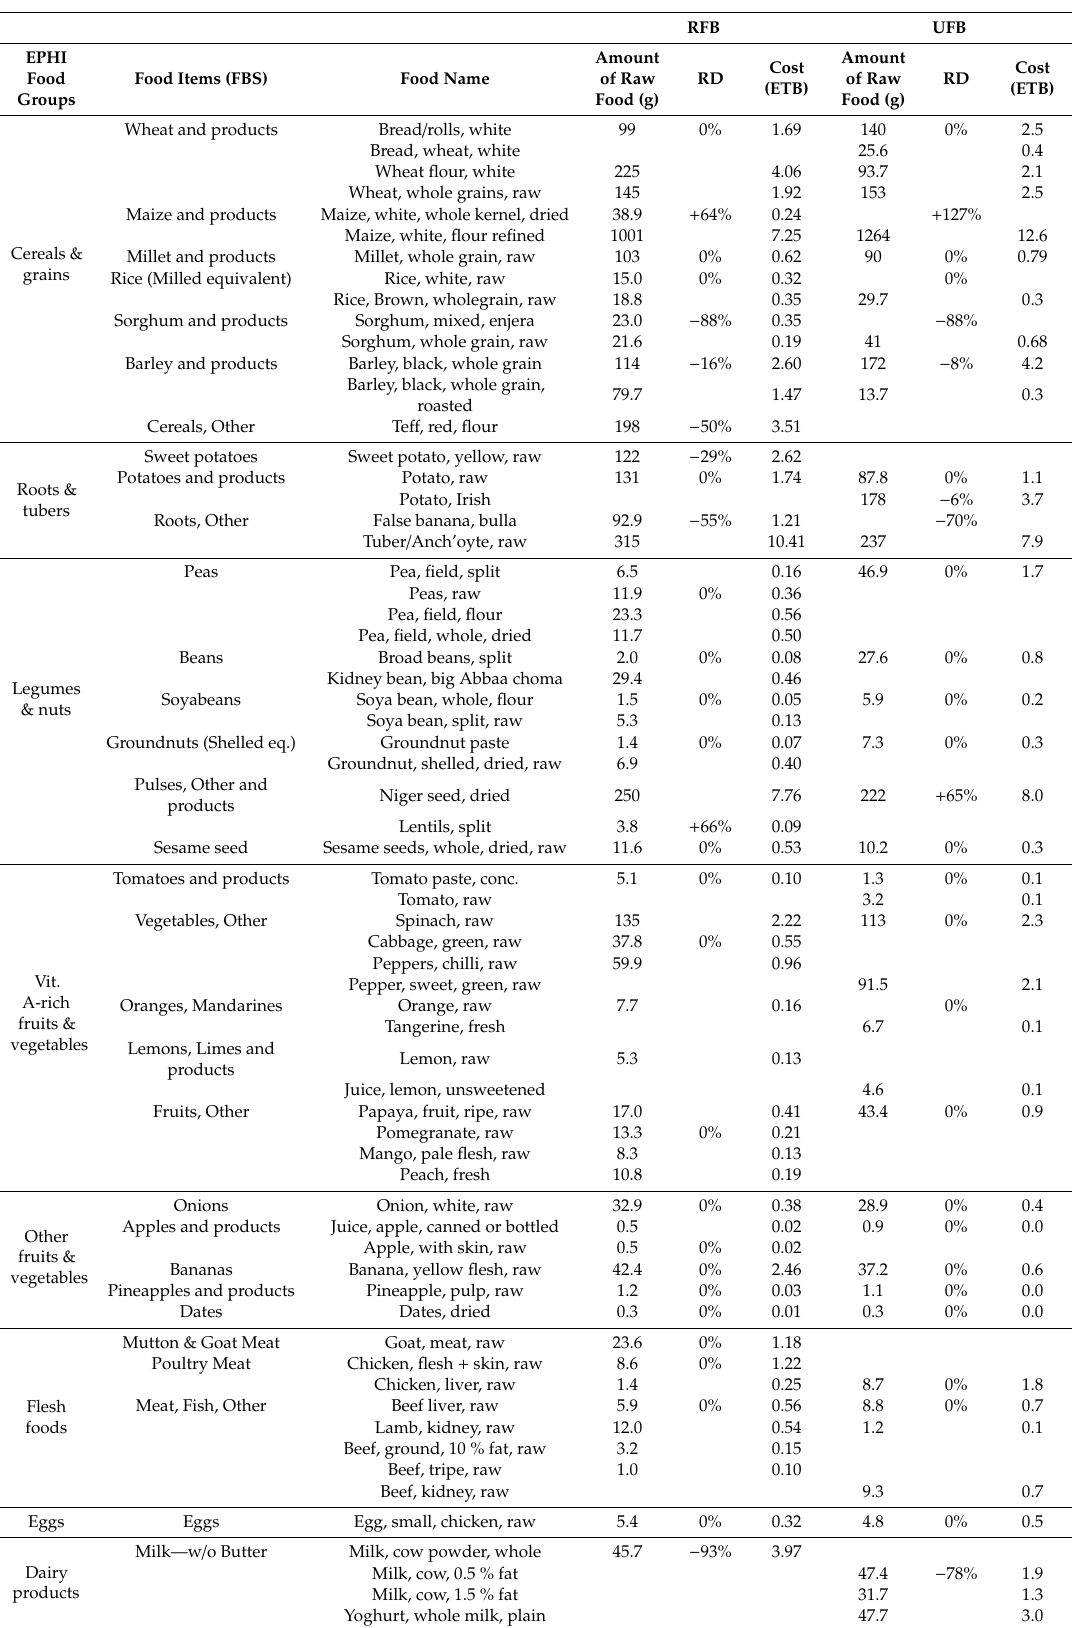
Table 5. The nutritionally adequate Ethiopian rural (RFB) and urban (UFB) food baskets for the lowest income households (maximum cost of ETB